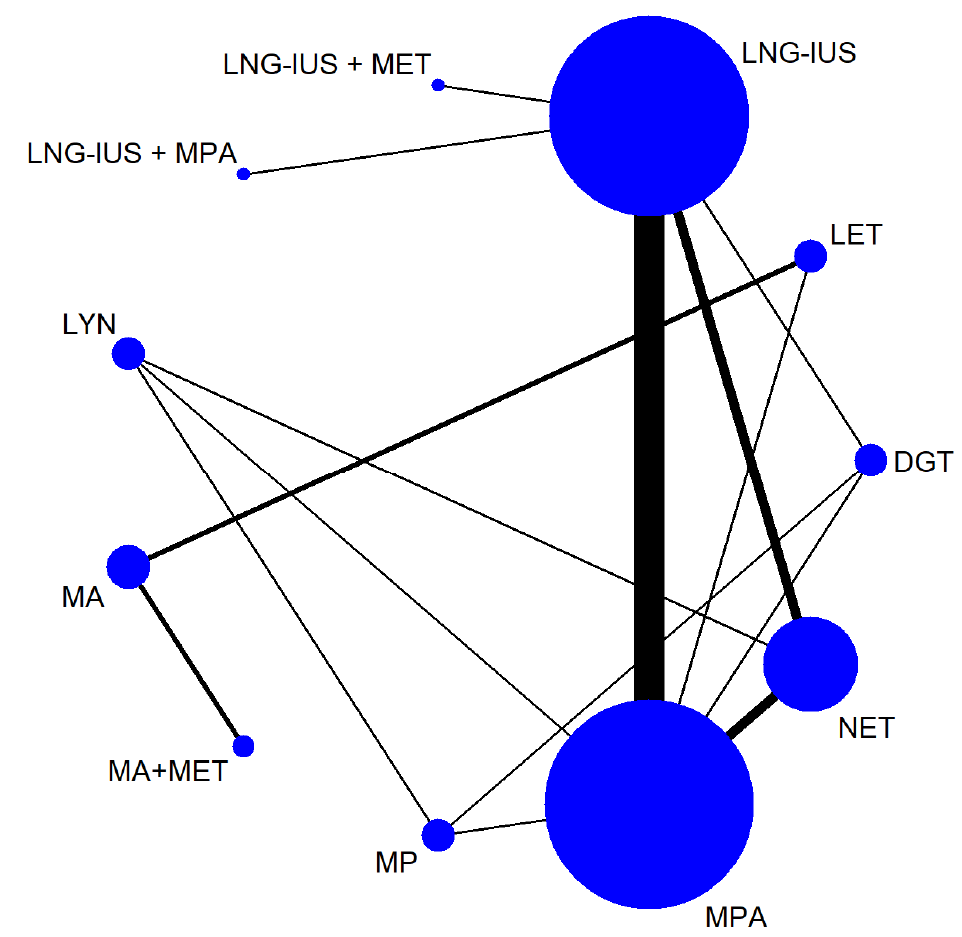
Figure 2. Network of comparisons among treatments for endometrial hyperplasia. The node size is proportional to the number of participants randomly assigned to that